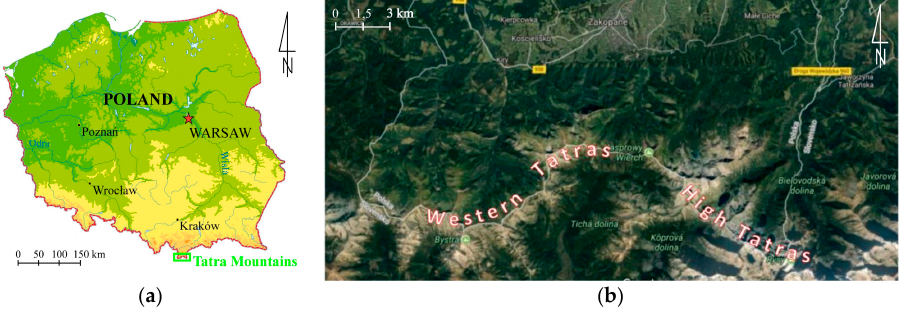
Figure 1. Location of the study area: ( a ) location of the Tatra Mountains in Poland, ( b ) location of the Western Tatras and High Tatras (source: own study based on [60]).